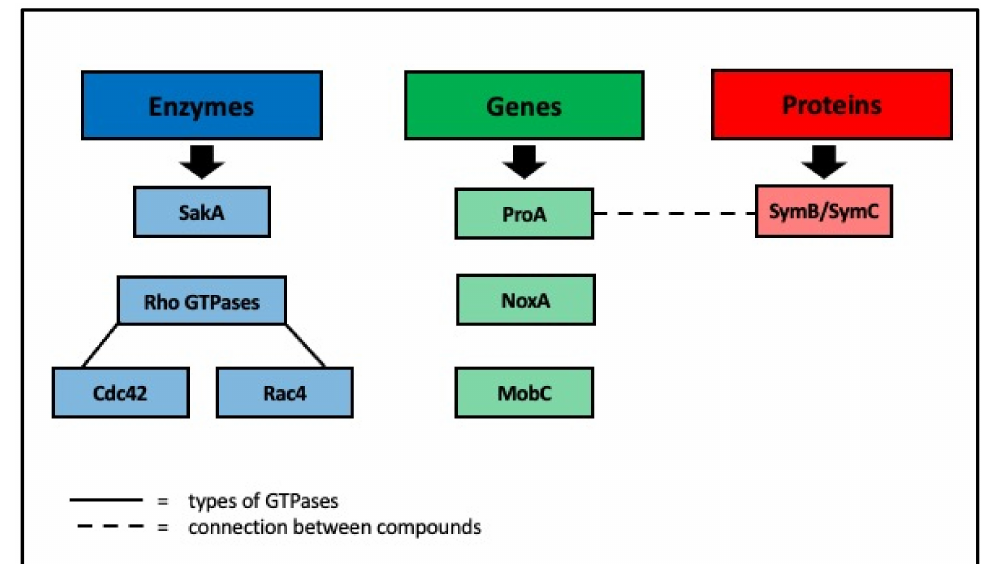
Figure 1. A visual representation of putative enzymes, genes and proteins necessary for Epichloë endophyte and grass mutualism. SakA and NoxA regulate ROS production. Cdc42 and Rac4 regulate intercalary and hyphal network growth. ProA works with SymB/SymC to regulate endophyte growth. MobC is necessary for the symbiosis of the endophyte and